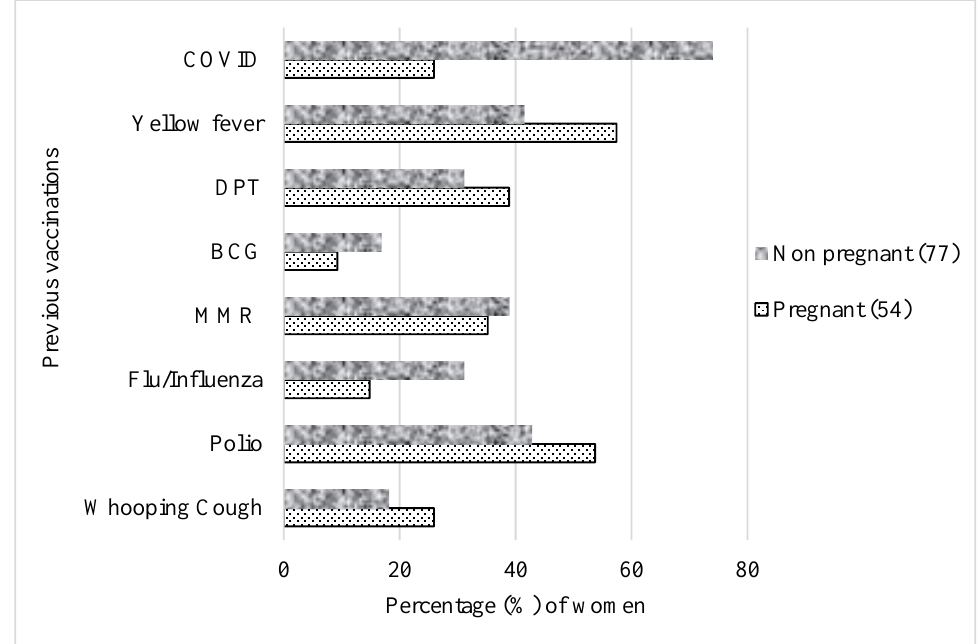
Figure 3. Previous vaccinations based on pregnancy status. Participants selected multiple re- sponses. MMR — measles – mumps – rubella combination vaccine; DPT — diphtheria, pertussis and tetanus; BCG — Bacille Calmette – Guérin.